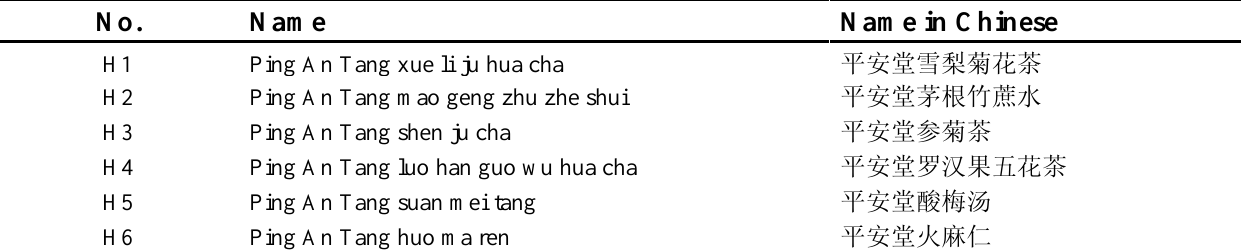
Table 1. Samples of 51 herbal (H1–H28) and tea (T1–T23) infusions.